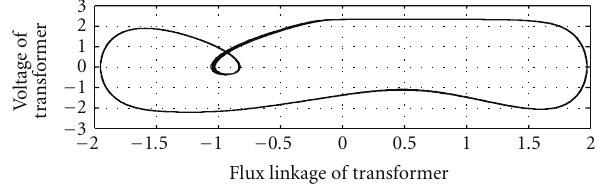
Figure 3: Phase plan diagram for q = 7 (ZnO e ff ect).